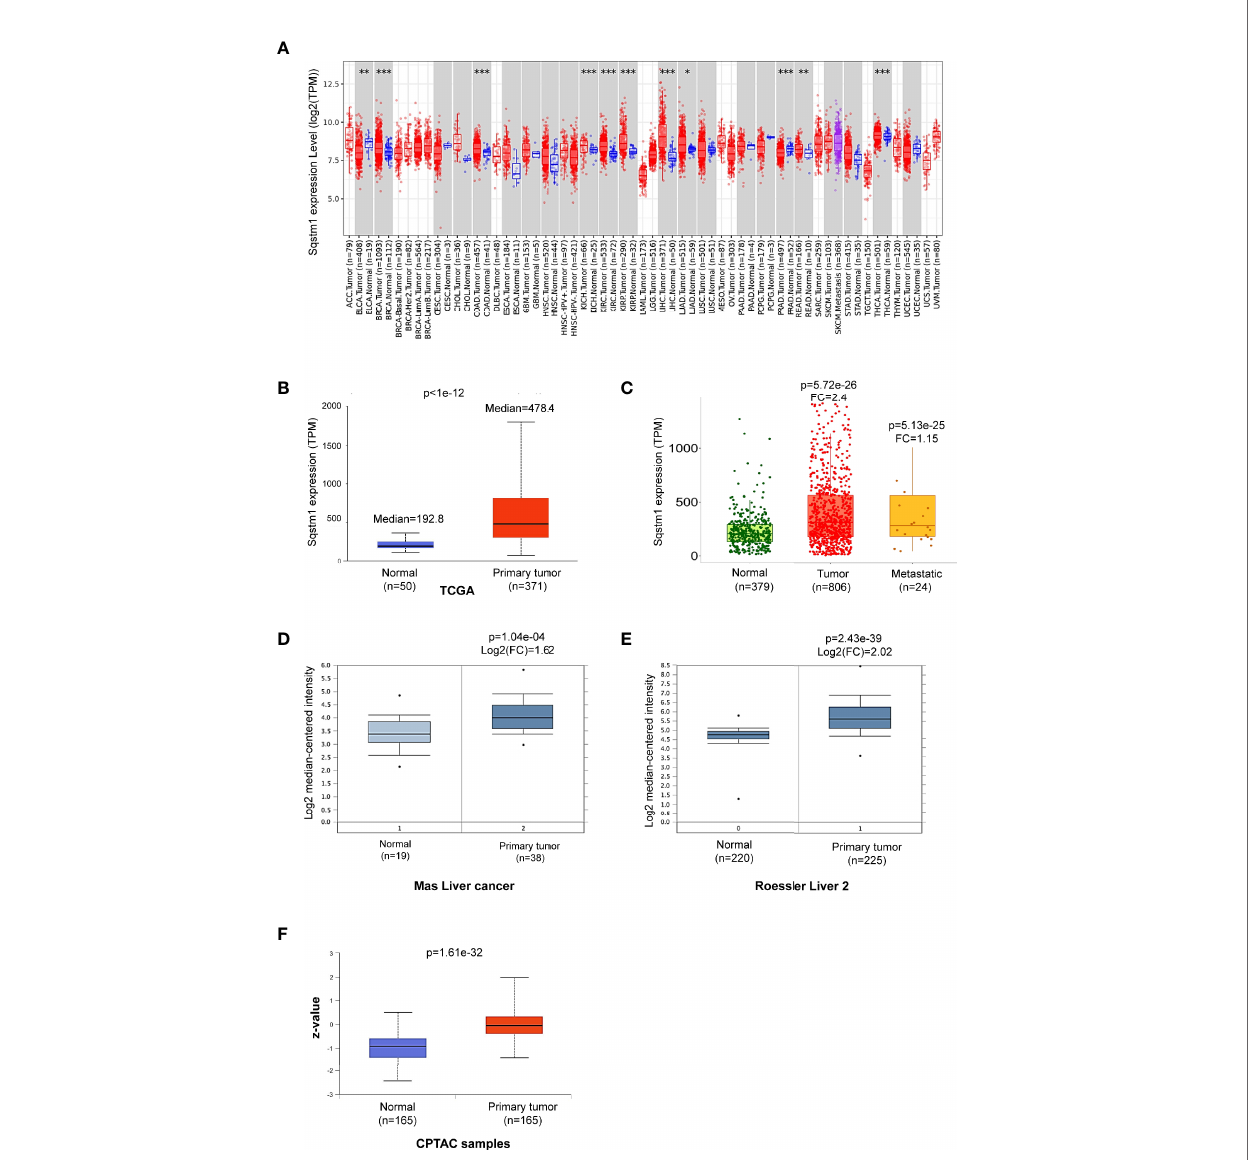
FIGURE 2 | Sqstm1 is upregulated in LIHC. (A) Deregulation of Sqstm1 at the transcriptional level in various cancers (*p < 0.05; **p < 0.01; ***p < 0.001). Methodology was described in detail in (20, 21). Blue: Normal tissues; Red: Tumor tissues. Pink: Tumor tissues without normal tissue controls; Purple: Metastasis tumor tissues. ACC, Adrenocortical carcinoma; BLCA, Bladder Urothelial Carcinoma; BRCA, Breast invasive carcinoma; CESC, Cervical squamous cell carcinoma and endocervical adenocarcinoma; CHOL, Cholangio carcinoma; COAD, Colon adenocarcinoma; DLBC, Diffuse large B-cell lymphoma; ESCA, Esophageal carcinoma; GBM, Glioblastoma multiforme; HNSC, Head and Neck squamous cell carcinoma; KICH, Kidney chromophobe; KIRC, Kidney renal clear cell carcinoma; KIRP, Kidney renal papillary cell carcinoma; LAML, Acute myeloid leukemia; LGG, Brain lower-grade glioma; LIHC, Liver hepatocellular carcinoma; LUAD, Lung adenocarcinoma; LUSC, Lung squamous cell carcinoma; MESO, Mesothelioma; OV, Ovarian serous cystadenocarcinoma; PAAD, Pancreatic adenocarcinoma; PCPG, Pheochromocytoma and paraganglioma; PRAD, Prostate adenocarcinoma; READ, Rectum adenocarcinoma; SARC, Sarcoma; SKCM, Skin cutaneous melanoma; STAD, Stomach adenocarcinoma; TGCT, Testicular germ cell tumors; THCA, Thyroid carcinoma; THYM, Thymoma; UCEC, Uterine corpus endometrial carcinoma; UCS, Uterine carcinosarcoma; UVM, Uveal melanoma. (B – E) Sqstm1 transcription is upregulated in LIHC. (F) Sqstm1 protein level is upregulated in LIHC. (A) is the results from TIMER2 portal, (B, C) from UALCAN, (D, E) from Oncomine, and (F) from UALCAN. Median Value = median(logData); Median-centered intensity= logData-Median Value. Z-values represent standard deviations from the median across LIHC